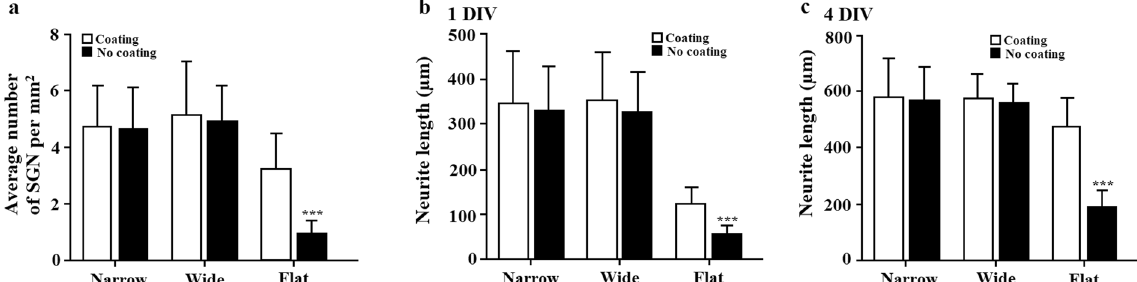
Figure 12. Influence of a substrate coating on neuronal presence and growth. ( a ) Bars and standard deviations showing an effect of substrate coating on SGN density. * indicates significant differences between coated and non-coated flat surfaces of the CMOS chip: *** P < 0.001 (Student’s t-test). Bars and standard deviations showing an effect of substrate coating on neurite length after ( b ) 1 DIV and ( c ) 4 DIV. * indicates differences between coated and non-coated flat surfaces of the CMOS chip: *** P < 0.001 (Student’s